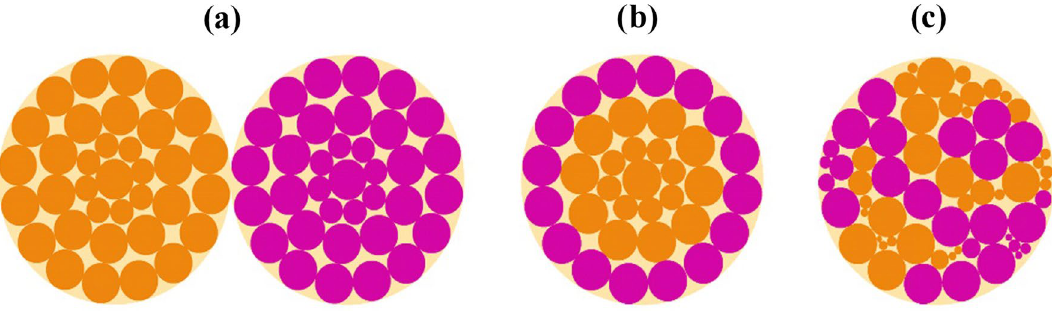
Fig. 8 Schematic of BNPs structure depend on two-step synthesis method and medium condition. Dumbbell a , core–shell b , and alloy c